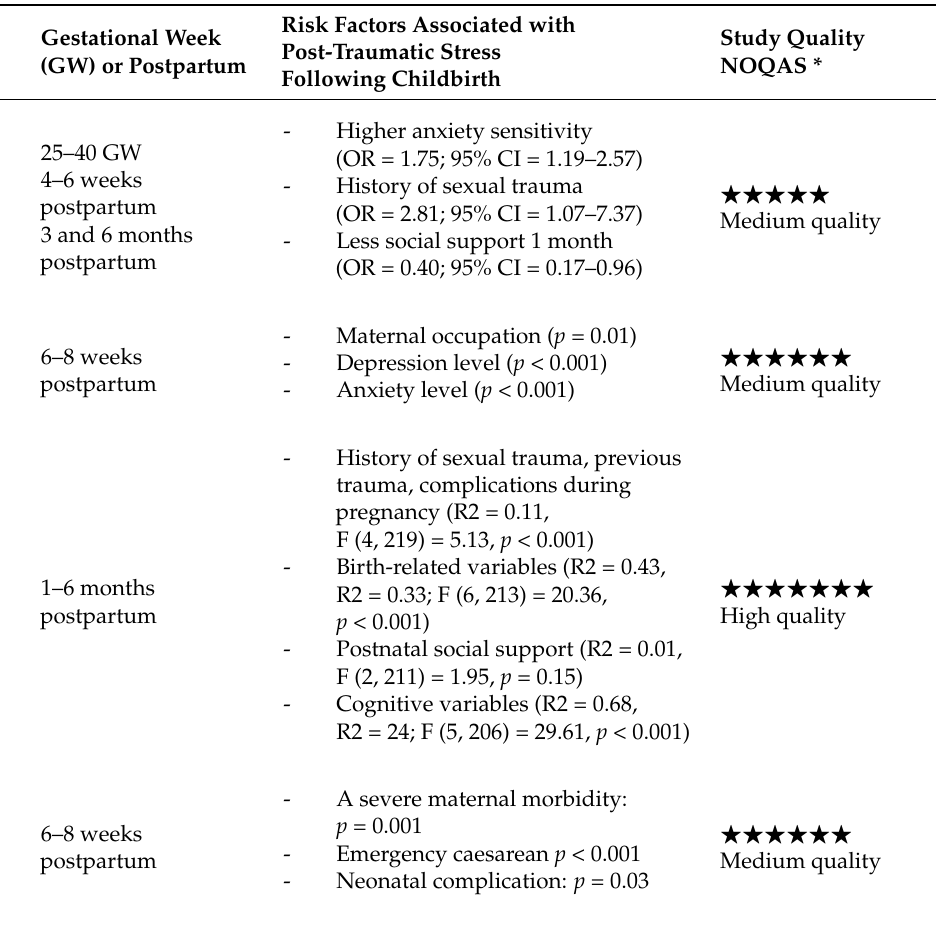
Table A1. Characteristics of the studies selected in the review for risk factors for PTSD after